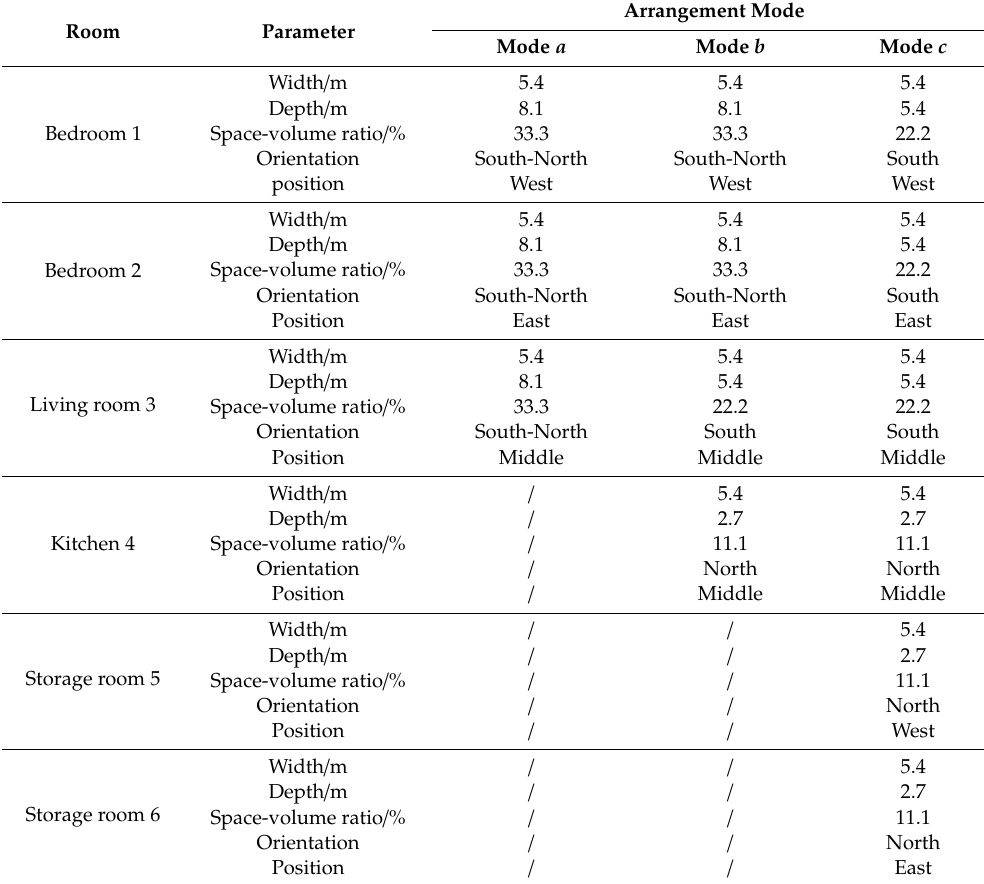
Table 2. Parameters of space-arrangement